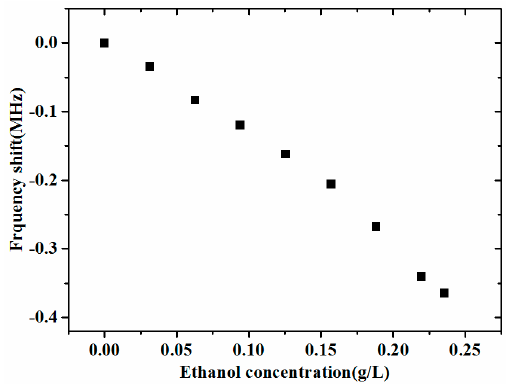
Figure 9. The frequency shift of the presented sensor sample with changed ethanol concentration.